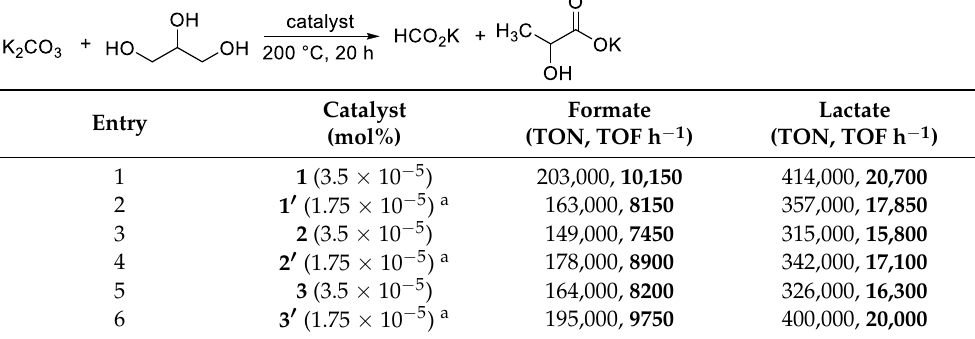
Figure 2. X-ray crystal structure of catalyst 3′ .